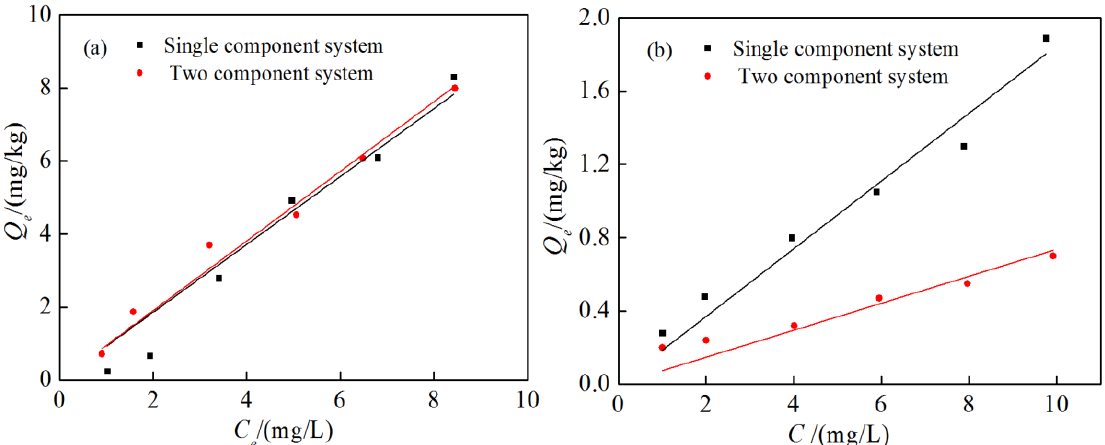
Figure 4. Competitive adsorption of 1,2 − dichloropropane and TCP on aquifer medium. (The initial concentration of the target compound was 1, 2, 4, 6, 8, and 10 mg/L, and the concentration of the coexisting solute was 2 mg/L). ( a ) Effect of TCP on the adsorption of 1,2 − dichloropropane on the aquifer medium; ( b ) Effect of 1,2 − dichloropropane on the adsorption of TCP on the aquifer medium.